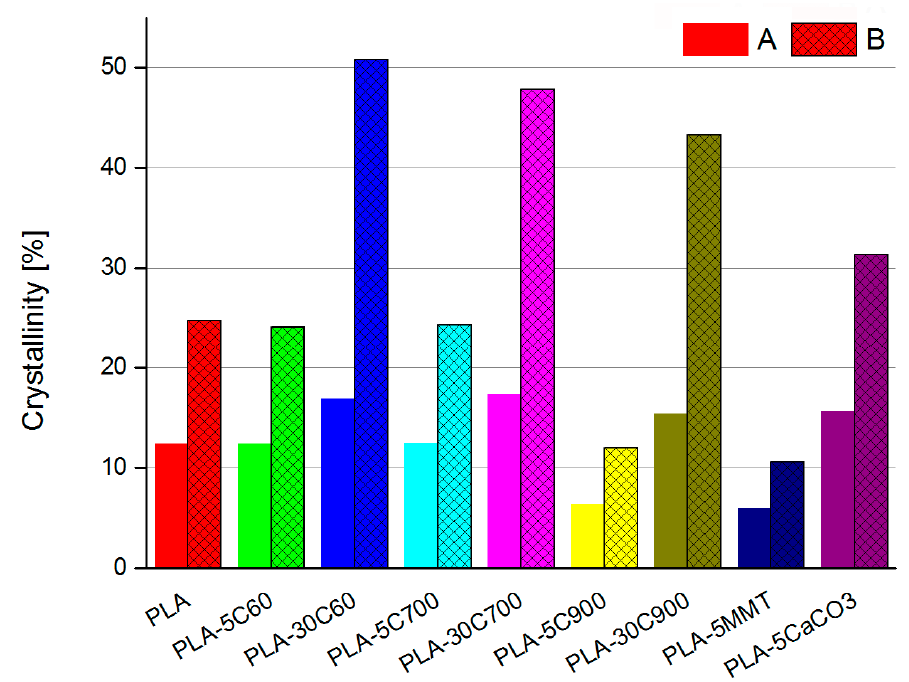
Figure 5. Comparison of the crystallinity calculated using two different ways. A—heat of fusion, crystallization as well polymer to filler ratio taken into consideration; B—simple calculation relying only on heat of crystallisation